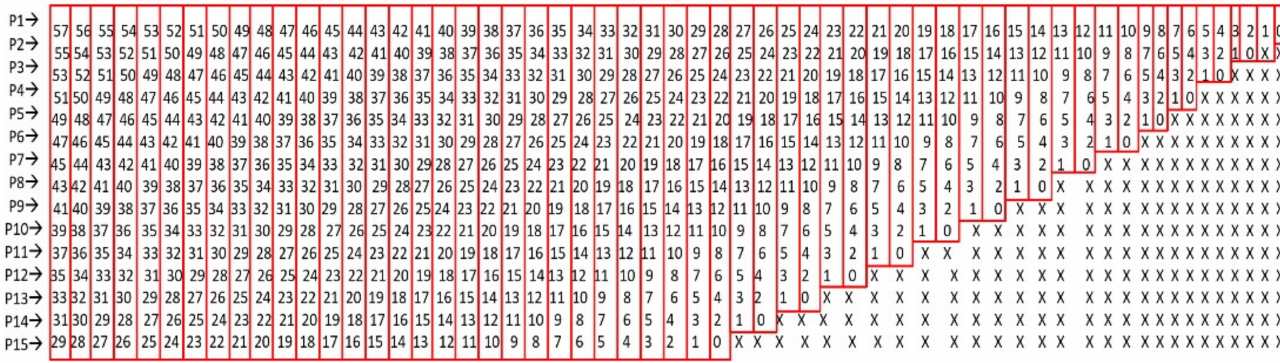
Figure 4. Alignment of shifted partial